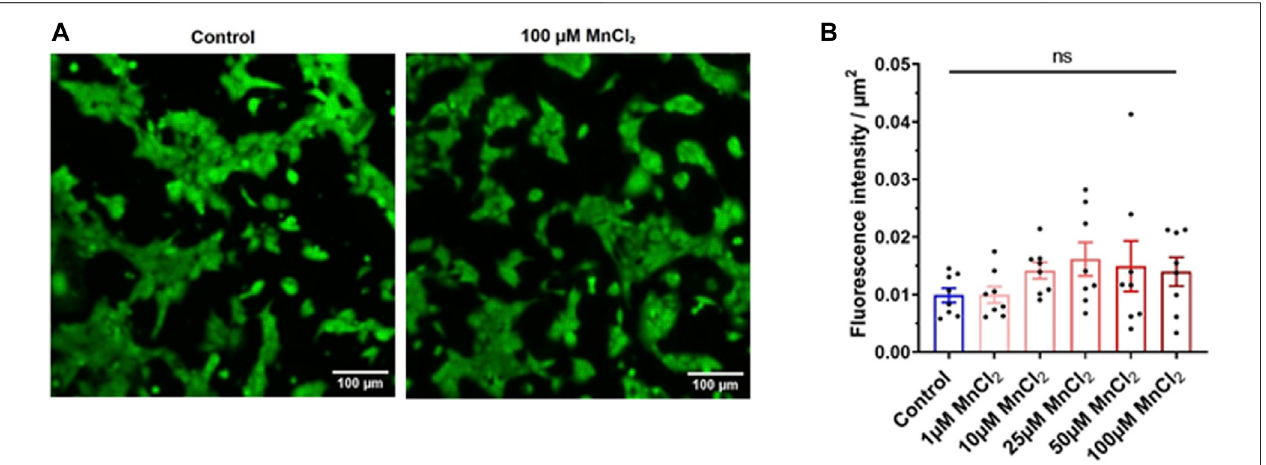
FIGURE 2 | Effect of MnCl 2 on the cell viability of HL-1 cells. (A) Representative image of the calcein fl uorescence in HL-1 cells in control (left) and 100 µM MnCl 2 (right) condition. (B) Total fl uorescence of calcein expressed par µm 2 between the control condition and the different MnCl 2 concentrations ( n = 8). ns, no signi fi cant.